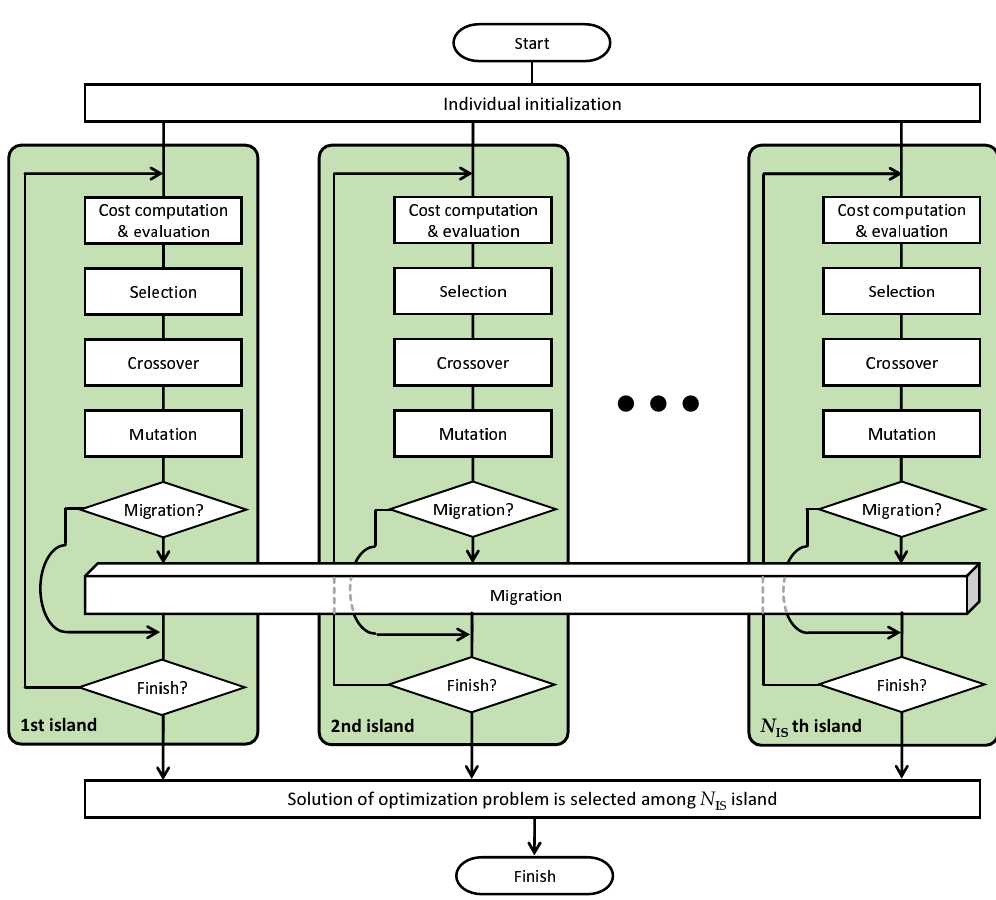
Figure 1. Overview of distributed genetic algorithm